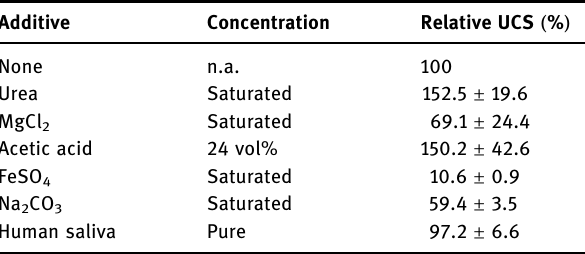
Table 2: E ff ect of additive incorporation on UCS of ERBs. UCS pre - sented as a % relative to no additive